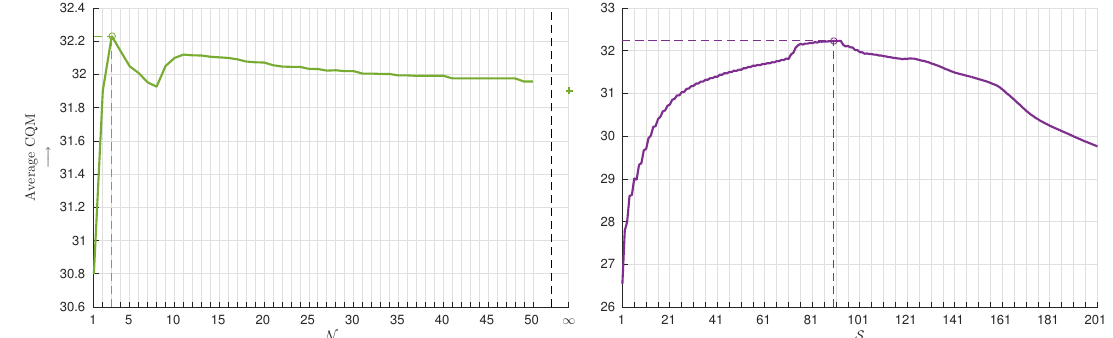
Figure 8. Average performance of LaBGen-P-Semantic with CV+U on the SBI+SBMnet-GT dataset when the parameters N and S vary around the default set of parameters proposed in Equation (27). The best average performance is indicated by a